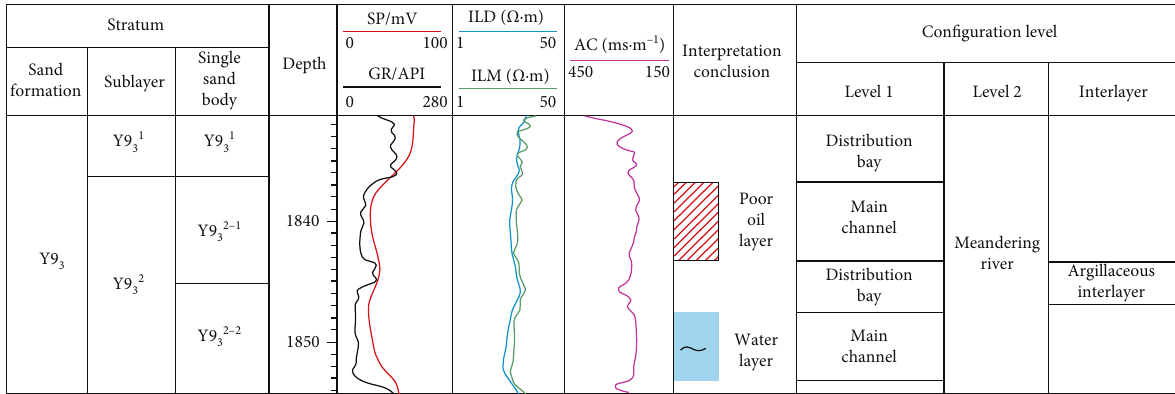
Figure 7: Schematic diagram of argillaceous interlayer in the Yan 9 32 layer (D4421-2). Table 2: Classi fi cation of sedimentary microfacies and its logging response of the Yan 9 32 layer. Sedimentary subfacies